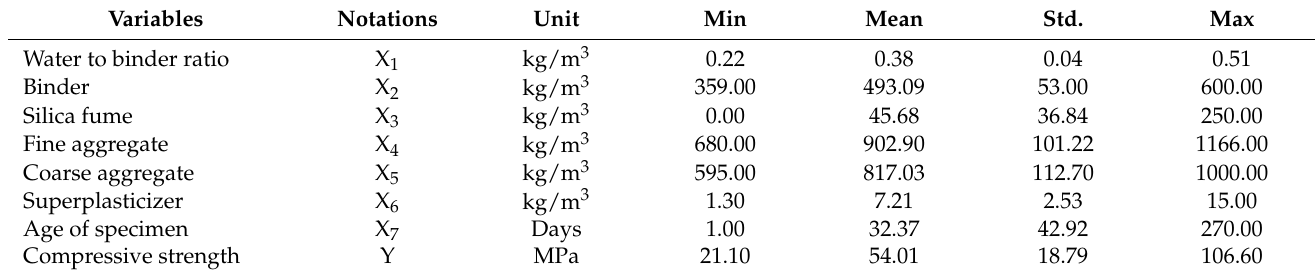
smallest number of data points. The scatter plots showing the correlation between the predictor variable and the CS as the modeled variable of the 4 datasets are demonstrated in Figures 1–4. Generally, these figures show weak linear correlations between the predictor variables and the CS of CSS and point out the need for advanced nonlinear analysis methods to predict the CS